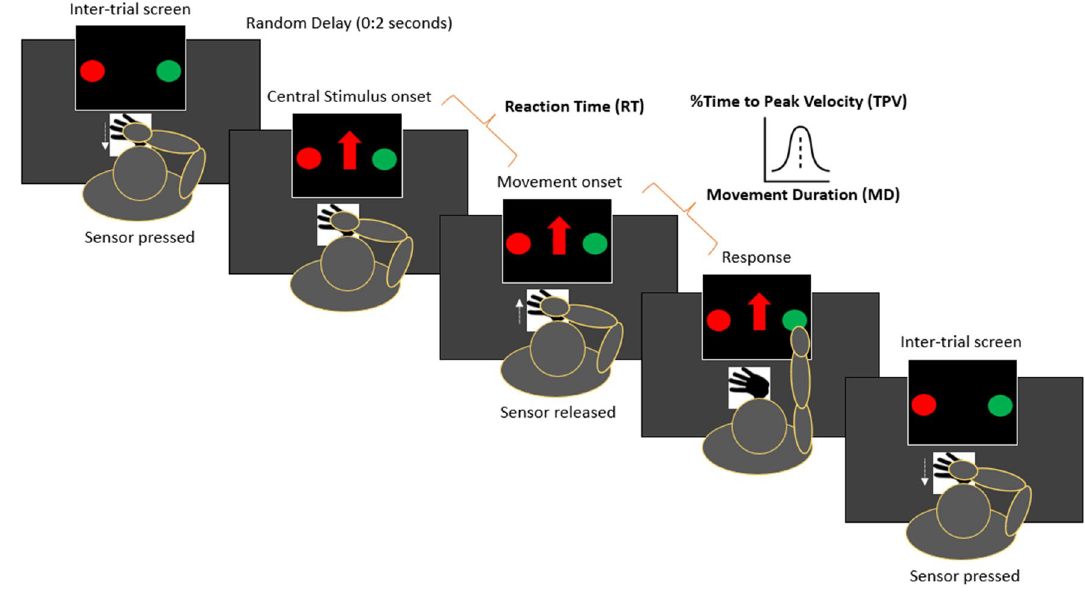
Figure 1. Set-up and